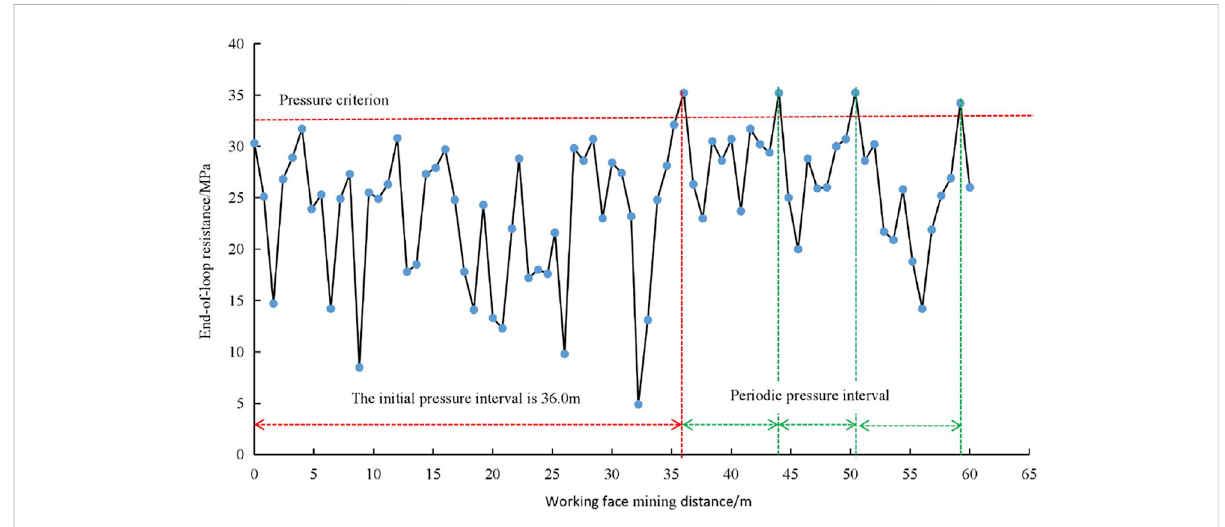
FIGURE 9 Curve of the end-of-loop resistance of the No. 40 hydraulic